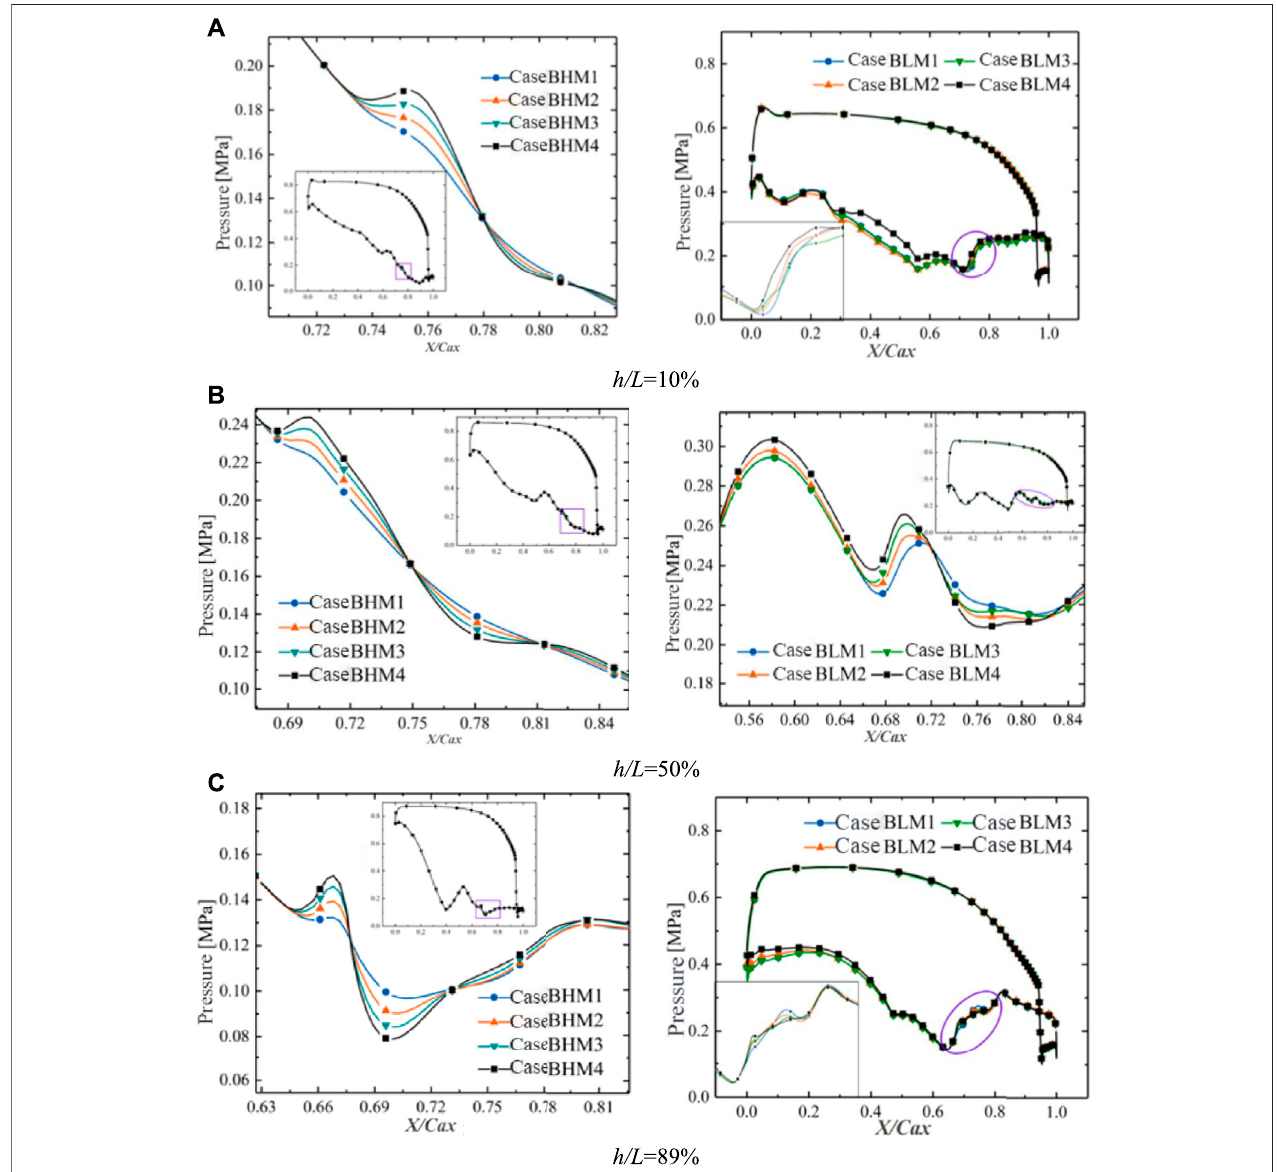
FIGURE 7 | The pressure distribution in different height sections for two degrees of reaction (DORs). (A) h/L = 10%, (B) h/L = 50%, and (C) h/L = 89%.